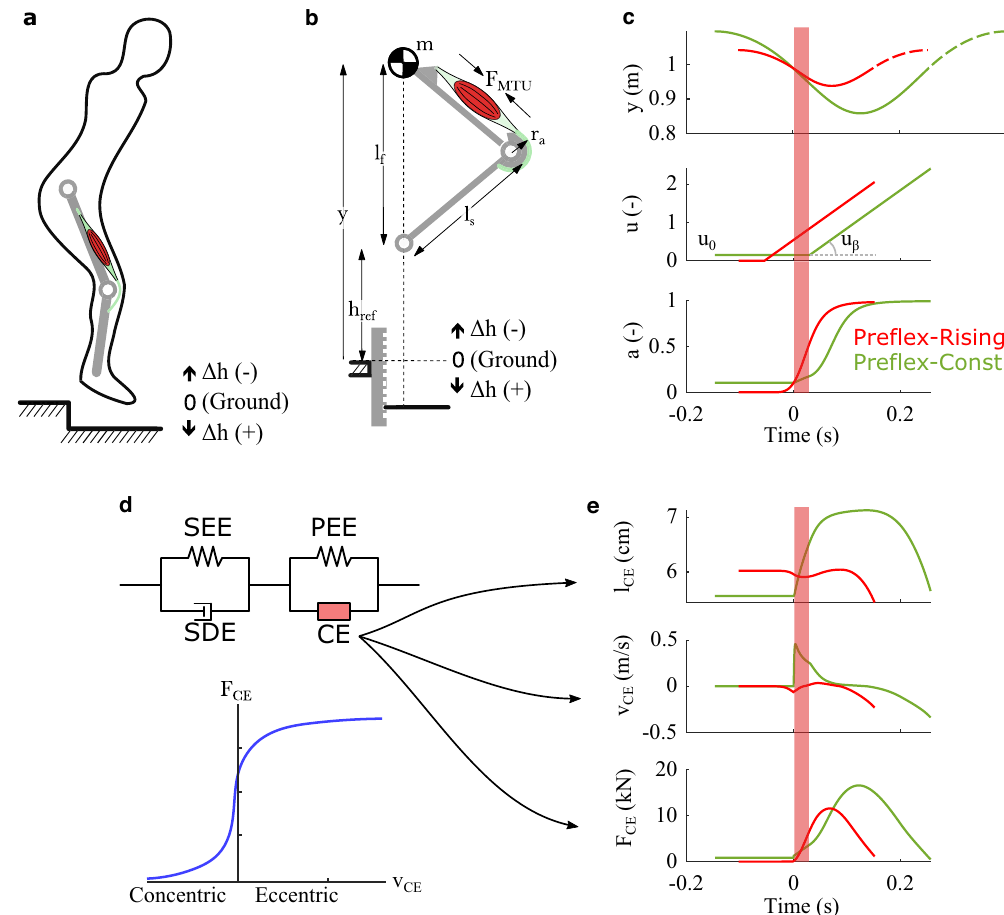
Figure 1. Study design. ( a ) Step perturbations present a challenge during agile locomotion because neuro- transmission delay affects a considerable fraction of the stance duration. Because of their instantaneous response to ground disturbances, the mechanical properties of muscle–tendon units may be critical to prevent falling. ( b ) We simulate vertical hopping of a massless, two-segment leg model to investigate the stabilising response of the muscle fibre’s force–velocity relation to step disturbance ∆ h . Here, h ref indicates the unperturbed periodic hopping height, and y is the vertical position of the point-mass m. Leg length during flight and leg segment length are indicated by l f and l s , respectively . F MTU is the force exerted by the muscle–tendon unit and r a the associated lever arm. ( c ) To stimulate the muscle and generate periodic hopping, we apply a ramp signal, with prestimulation value u 0 and slope u β . In Preflex-Const, the muscle stimulation starts at actual touch-down and stays constant ( u = u 0 ) until the end of the preflex duration (30 ms post touch-down, indicated by the colored bar, with t = 0 s being touch-down). In Preflex-Rising, the muscle stimulation starts before expected touch-down with u 0 = 0. Here, the stimulation onset is fixed in time and thus independent of the actual touch-down timing. We use the activation dynamics in Refs. 24,25 to convert the stimulation signal u into muscle activity a . We tuned Preflex-Const and Preflex-Rising to produce the same muscle activity at touch-down during unperturbed hopping: y shows the vertical trajectory of the center of mass for each stimulation strategy. Initial and final mass heights y are identical for each trajectory, indicating that both Preflex-Const and Preflex-Rising produced periodic hopping. ( d ) For our simulations, we use the Hill-type muscle model developed in Ref. 13 , which includes a contractile element (CE), a parallel elastic element (PEE), a serial elastic element (SEE), and a serial damper element (SDE). The force–velocity relation models the dependence of the muscle fibre force F CE on the muscle fibre velocity v CE . Shortening velocities (negative v CE ) define the concentric region of the force–velocity relation, while lengthening velocities (positive v CE ) define the eccentric region. ( e ) Length ( l CE ), velocity ( v CE ) and force traces ( F CE ) of the muscle fibres during unperturbed hopping with Preflex-Const and